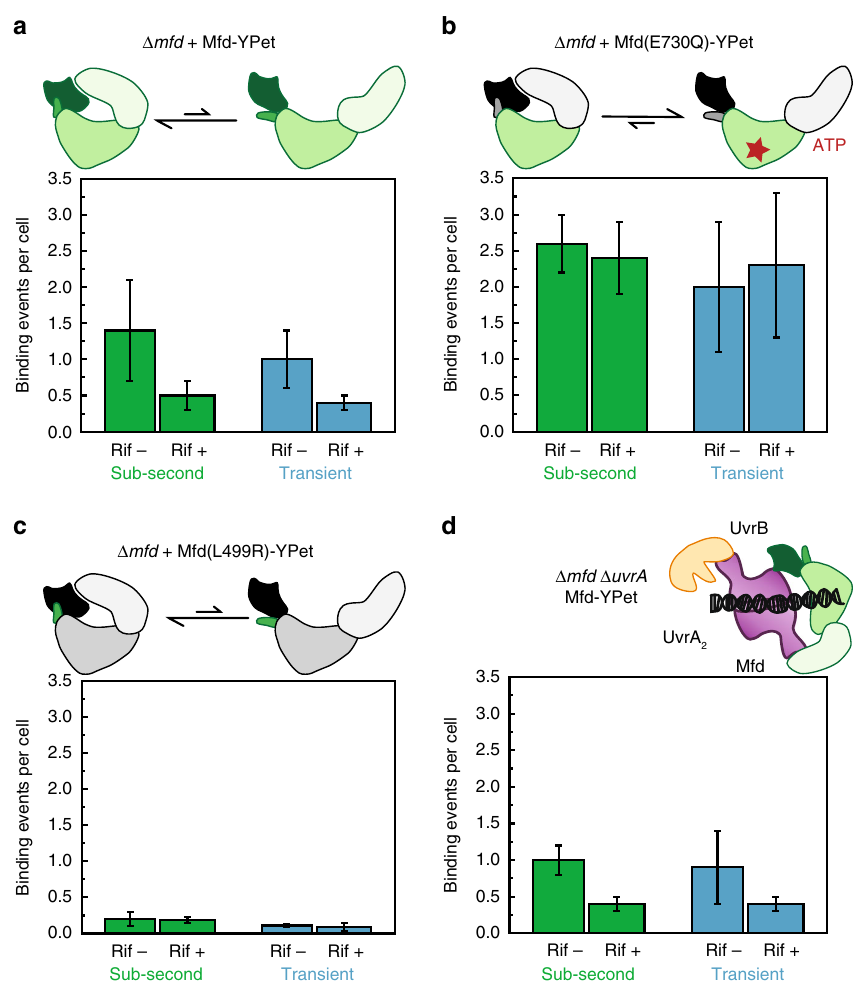
Fig. 5 In fl uence of rifampicin on binding of plasmid-based Mfd-YPet and mutants. Bar plots represent sub-second (green) and transient (blue) binding events detected in a − c Δ mfd cells expressing a Mfd-YPet, b Mfd(E730Q)-YPet and c Mfd(L499R)-YPet, and in d Δ mfd Δ uvr A cells expressing Mfd-YPet. Cells grew in the absence (Rif – ) or presence of Rif (Rif + , 50 µ L per mL) for 1 h in the fl ow cell prior to imaging. Error bars are standard deviations from three experiments. a − c Cartoons illustrate the dynamic equilibrium of conformational states of Mfd and mutants. d The cartoon illustrates the hypothetical complex UvrB-UvrA 2